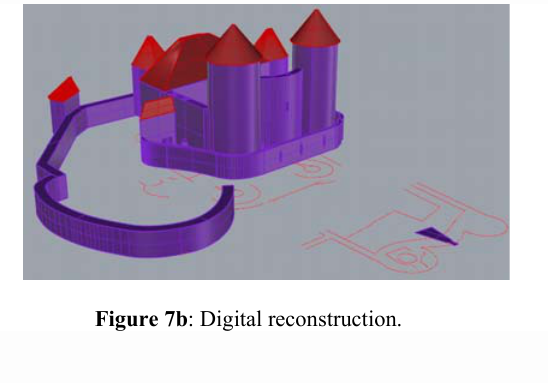
Figure 7b : Digital